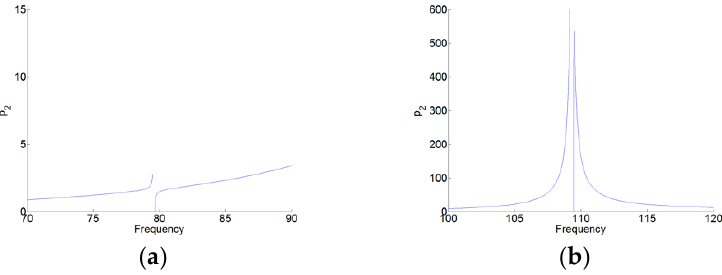
Figure 8. Zoom of 𝑝 1 (𝑡) in Figure 7a. ( a , b ) around the two resonant frequencies of the cavity.